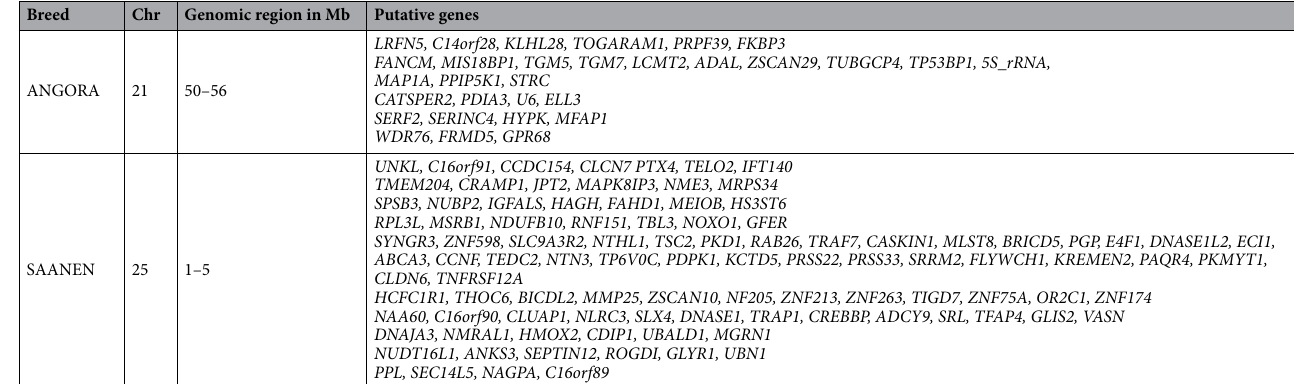
Table 2. List of candidate gene retrieved inside the genomic regions included in the interval of 1 Mb on both sides of selective sweep detected by